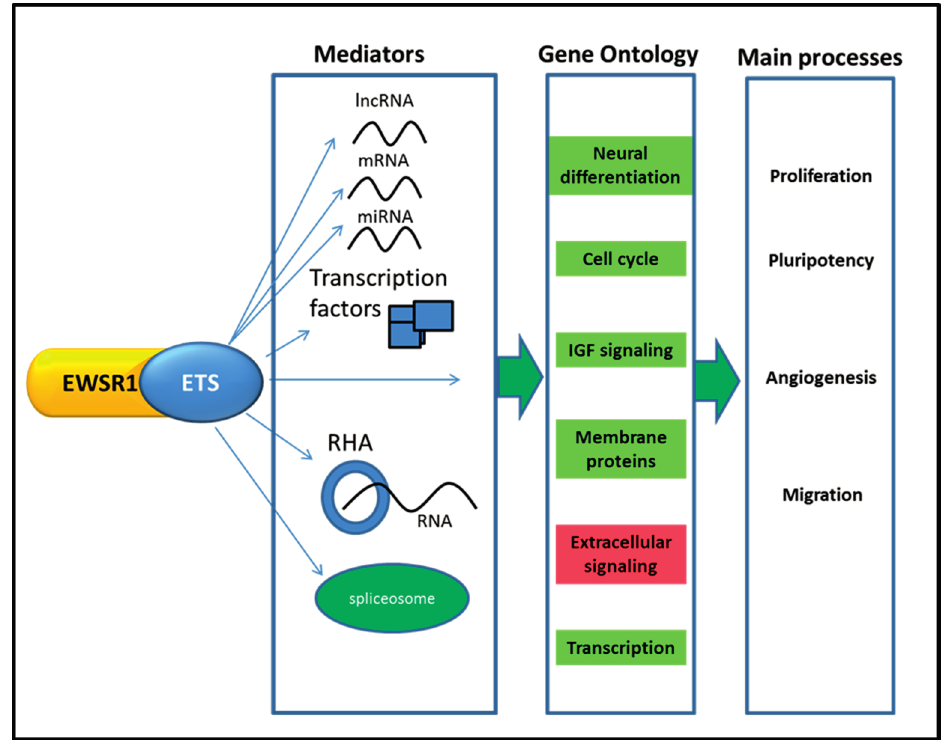
Figure 3. The influence of EWSR1-ETS fusion protein at the transcriptome